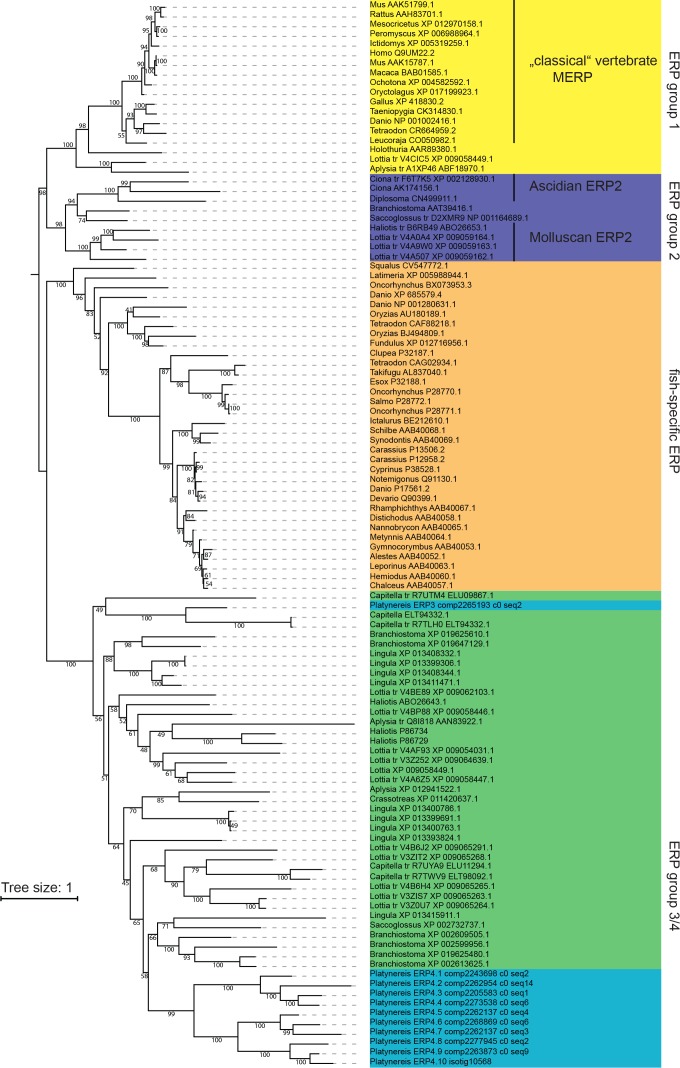
Maximum likelihood phylogeny of Ependymin-related proteins using the same alignment and settings as in Figure 6a.For better visibility, the tree is shown as rooted at the split between ERP group one and ERP group 2. Platynereis sequences are labelled with a systematic nomenclature following the apparent phylogeny, all other entries are labelled with genus_and Accession-Number. For cases in which translated (tr) genomic regions were initially used, two accession numbers are given.